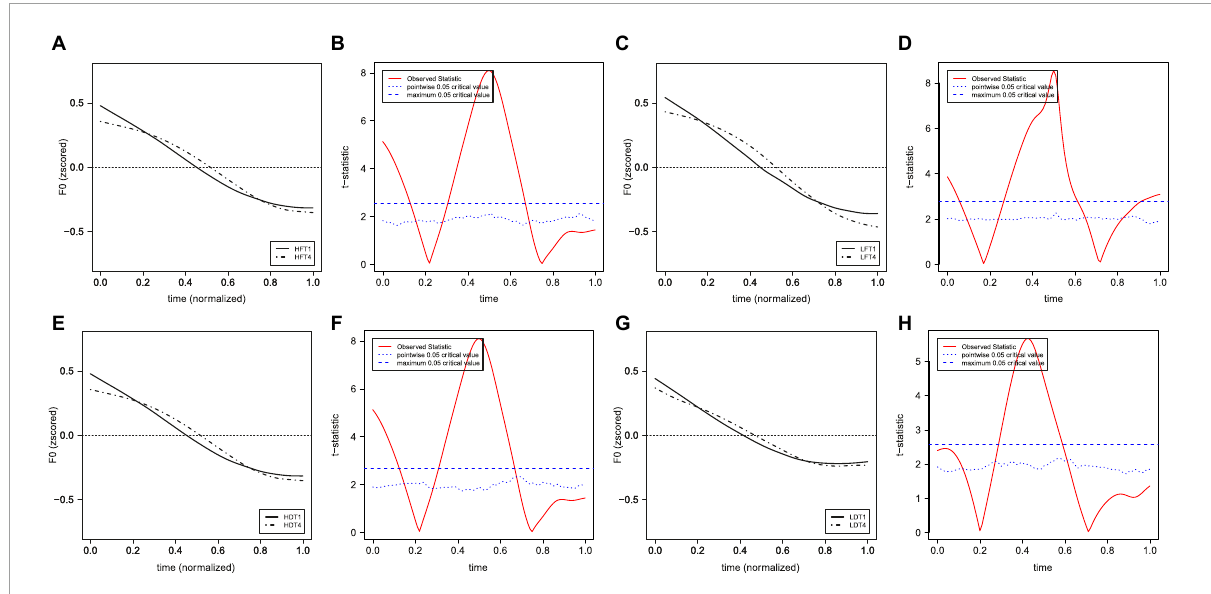
FIGURE4 The average of the (normalized) F0 curves for T1 and T4 in the four lexical conditions produced by young participants [ (A) HF; (C) LF; (E) HD; (G) LD] and their functional t -test statistic [ (B) HF; (D) LF; (F) HD; (H) LD]. The solid lines represent the F0 curves of T1, and the dot-dash lines represent the F0 curves of T4.